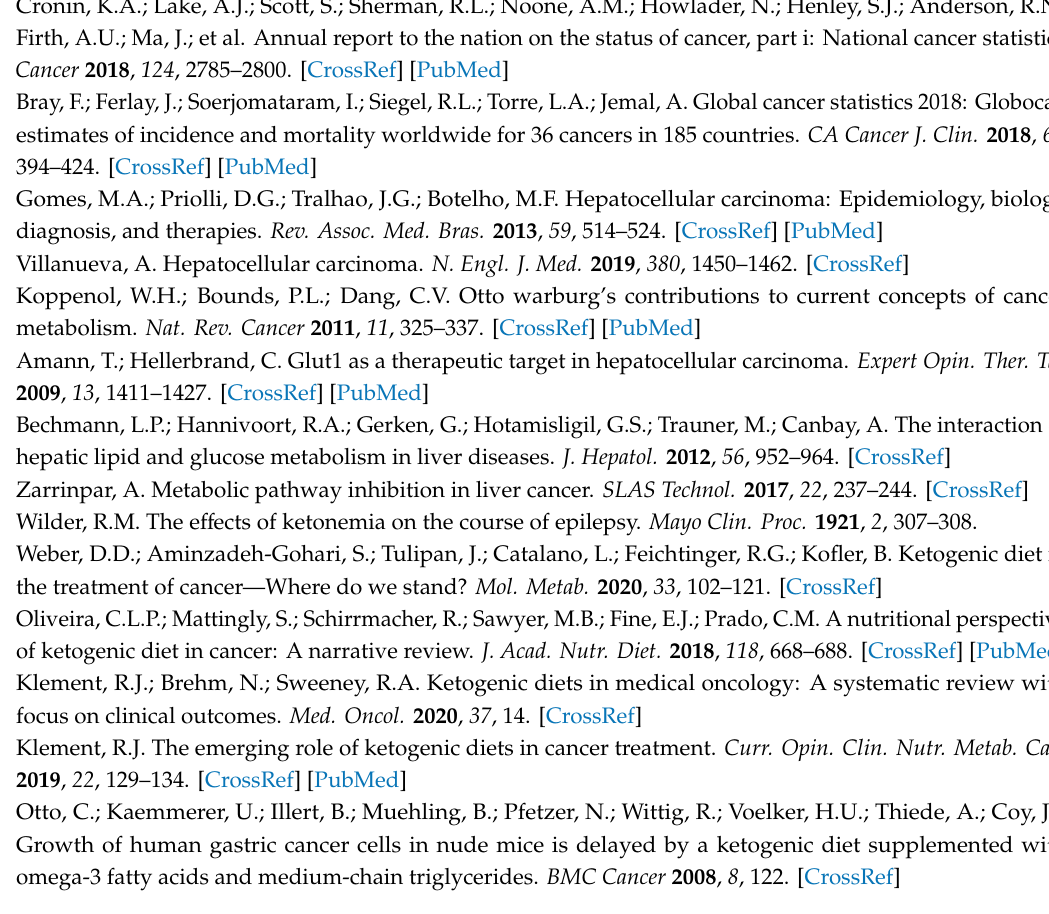
Figure S1: KD feeding did not induce any side e ff ects in mice, Figure S2: KEGG enrichment pathway: FXR / RXR activation, Figure S3: KEGG enrichment pathway: LXR / RXR activation, Figure S4: HMGCS2 overexpression did not a ff ect fatty acid, triglyceride, and cholesterol synthesis in both Huh-7 and Hep3B cells, Figure S5: HMGCS2 expression did not a ff ect the glycolysis signaling pathway in HCC cells, Figure S6: HMGCS2 overexpression did not a ff ect tumor growth in KD-fed mice and HMGCS2 expression did not influence the tumor inflammation, Figure S7: HMGCS2-overexpressed tumors did not influence expression of lipogenesis-related markers under KD feeding, Figure S8: HMGCS2-overexpressed tumors did not alter lipid content and showed no correlation with tumor weight, Figure S9: Establishment of cell lines with stable HMGCS2 overexpression and knockdown, Figure S10: Original unedited pictures and protein quantification of Figure 1, Figure S11: Original unedited pictures and protein quantification of Figure 3, Figure S12: Original unedited pictures and protein quantification of Figure 5, Figure S13: Original unedited pictures and protein quantification of Figure S4, Figure S14: Original unedited pictures and protein quantification of Figure S5, Figure S15: Original unedited pictures and protein quantification of Figure S7, Figure S16: Original unedited pictures and protein quantification of Figure